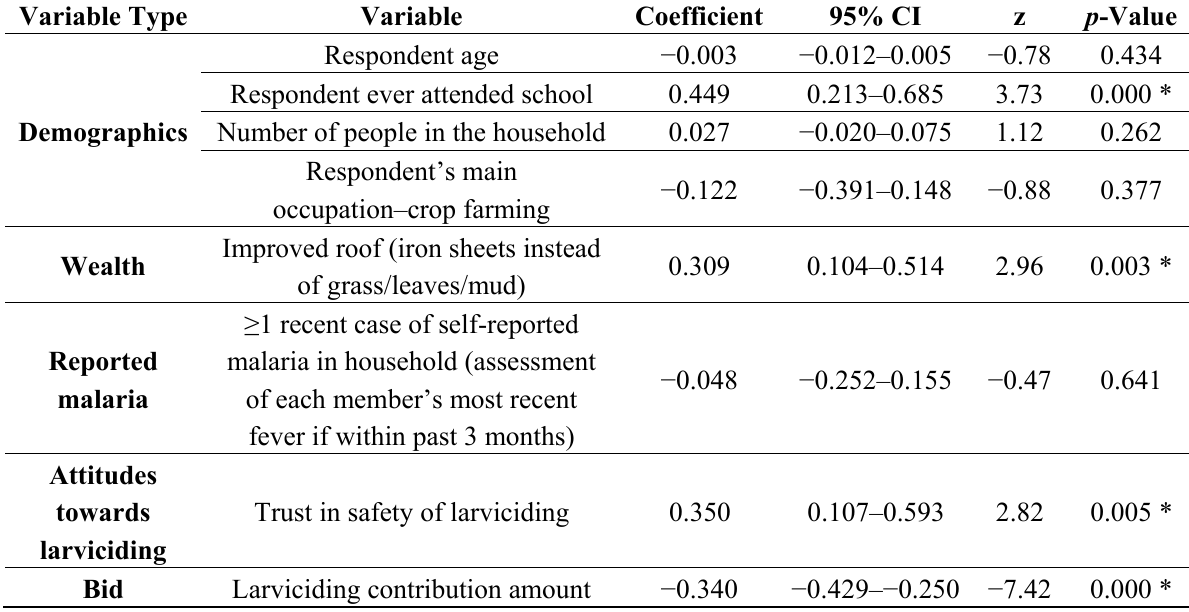
Table 5. Multivariate probit analysis of the associations between socioeconomic, self-reported malaria, and attitudinal indicators with expressed willingness to